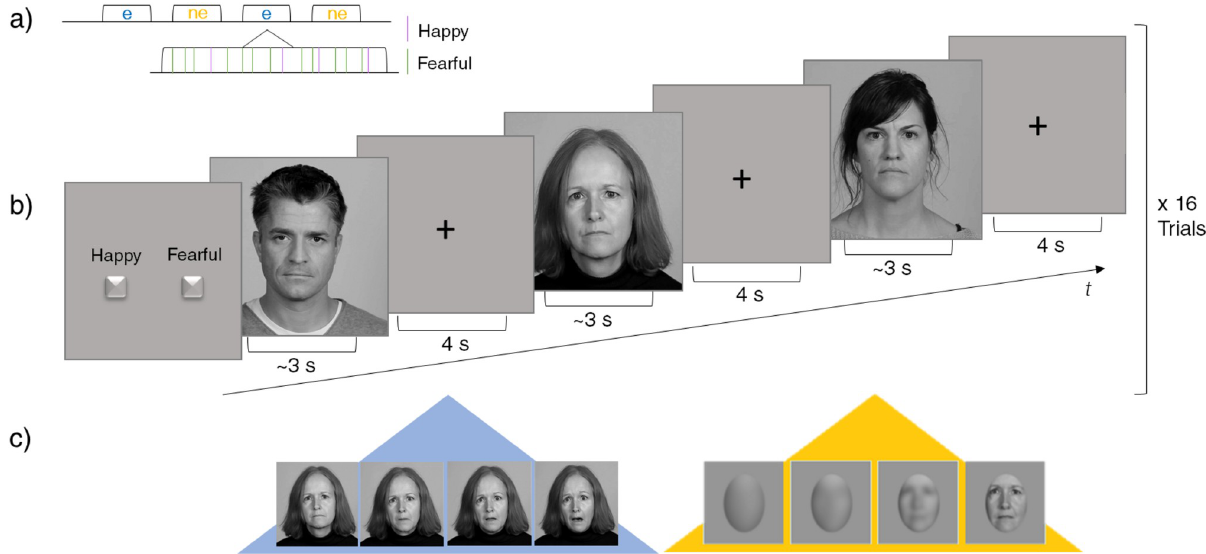
Fig 1. Schematic diagram of the task. a) Trials are presented in a mixed block- and event-related design with emotional (e) and non-emotional (ne) task blocks. b) At the beginning of each block, instructions indicate whether the participant has to indicate the emotion or the gender of the upcoming faces. One block includes 16 consecutive video trials. c) Videos depict actors/actresses posing from neutral to either happy or fearful facial expressions (blue background) or male or female actors/actresses from pixelated to high resolution (yellow background). The actor and actresses in the figure have given written informed consent (as outlined in PLOS consent form) to publish the photographs.